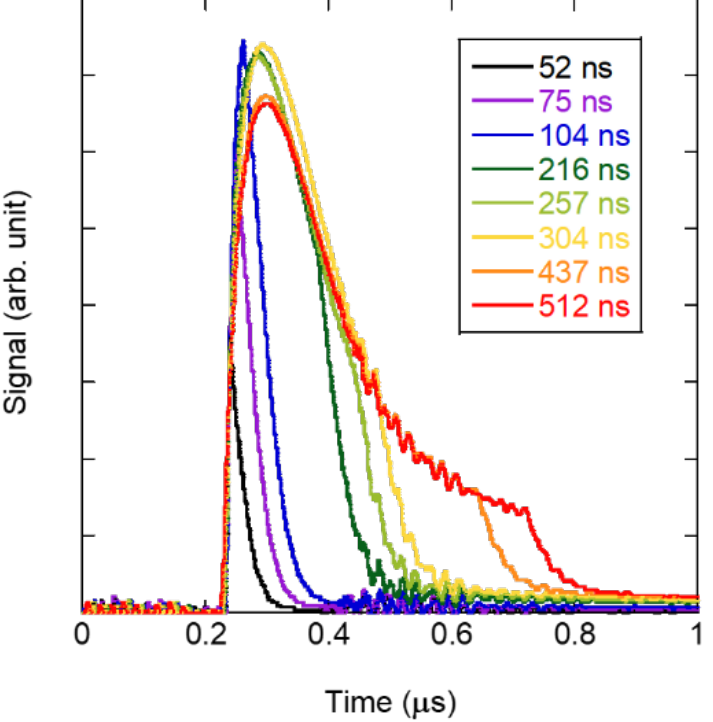
Figure 5. Variation of the impact laser pulse at different pulse-width settings. Figure 6 shows the results of the pulse-width dependence of the spectral power induced by the SPE method. The value on the vertical axis indicates the vibration spectral power P when the experimental sample was subjected to vibration at the same repetition frequency as the natural frequency observed with the impulse hammer, as shown in Figure 3a. We adjusted the repetition frequency of the SPE method to 2240 Hz for the copper disk and 2120 Hz for the brass disk. The frequencies were theoretically consistent wherein copper and brass exhibited close natural frequencies because these frequencies were determined proportional to the mechanical property parameter ( E / ρ ) 1/2 , where E denotes Young’s modulus and ρ is density. The pulse energy was fixed at 18 µ J using ND filters. The spectral power of the laser-induced vibration decreased with an increase in the pulse width. Pulse-width dependences, which were discussed in the interaction of nanosecond laser pulses with materials, are often explained through thermal diffusion. For example, a scaling law was reported for the laser-induced damage threshold (ablation threshold) caused by intense nanosecond laser pulses, whose dependence on the pulse width τ is proportional to τ 1/2 [22,23]. This can be explained by the coefficient τ 1/2 in the significant for its interaction with the irradiated material. The fittings in Figure 6 are